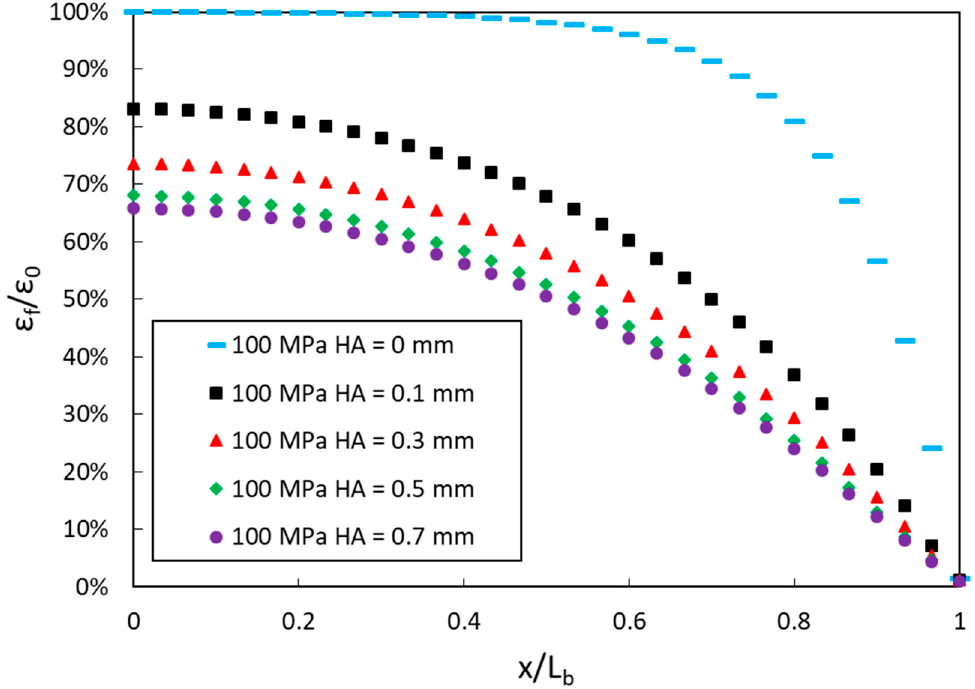
Figure 5. Strain transfer curves provided by the finite element model (FEM) for different values of HA (height of adhesive from the bottom of the distributed optical fiber sensor (DOFS) to the concrete surface in the groove).